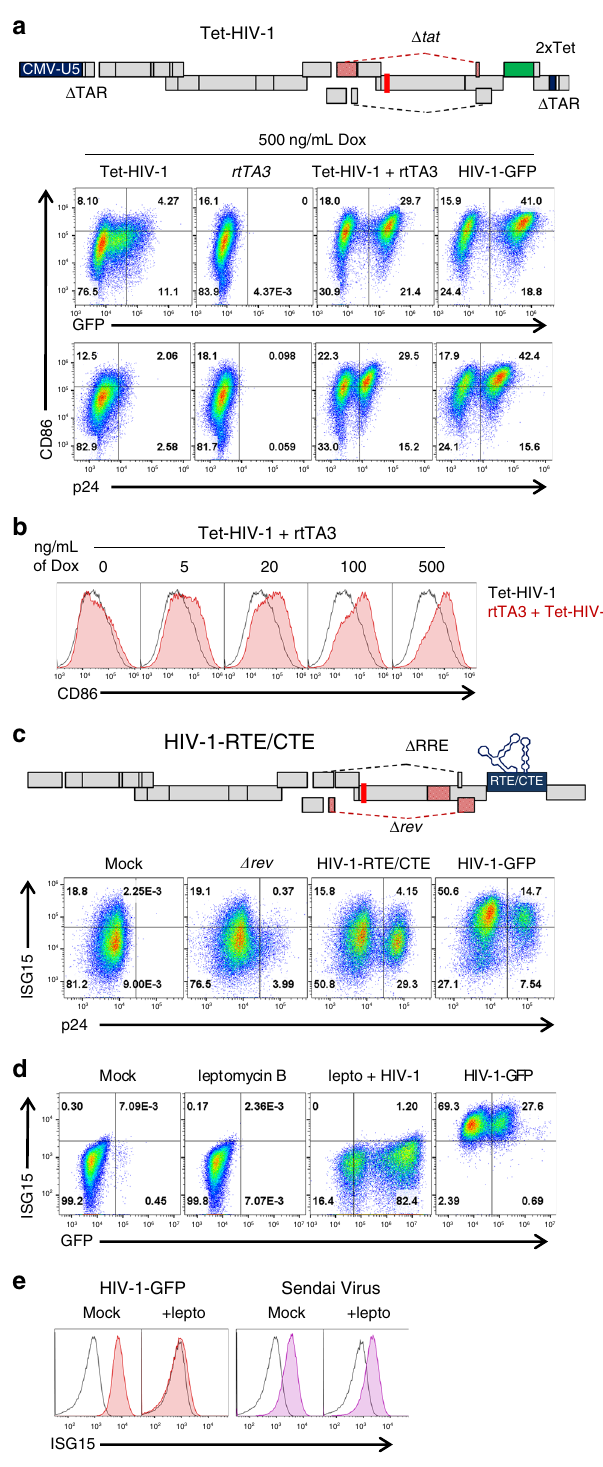
particular donors were excluded from experiments if percent enrichment deviated more than 5% from the numbers mentioned above, or if there was no increase in activation markers in response to control stimuli (LPS, Sendai virus, and wild-type HIV-1-GFP). HIV-1 vector production . HEK293E cells were seeded at 75% con fl uency in six- well plates and transfected with 6.25 μ L Transit LT1 lipid reagent (Mirus) in 250 μ L Opti-MEM (Gibco) with 2.25µg total plasmid DNA. 2-part HIV-1 vectors based on HIV-1-GFP 29 and described in detail in Supplementary Table 1 were NATURE COMMUNICATIONS| (2018) 9:5305